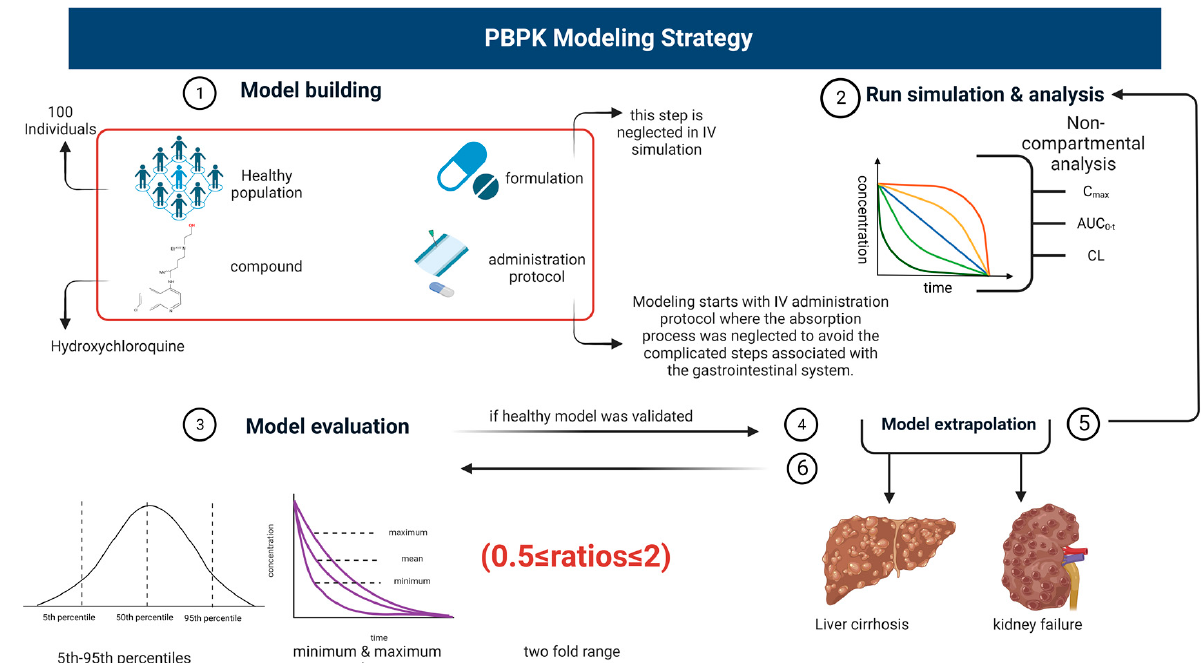
Figure 1. Schematic workflow diagram for the development of hydroxychloroquine PBPK model. The figure was created with BioRender.com with agreement number VR24U6YSZI.